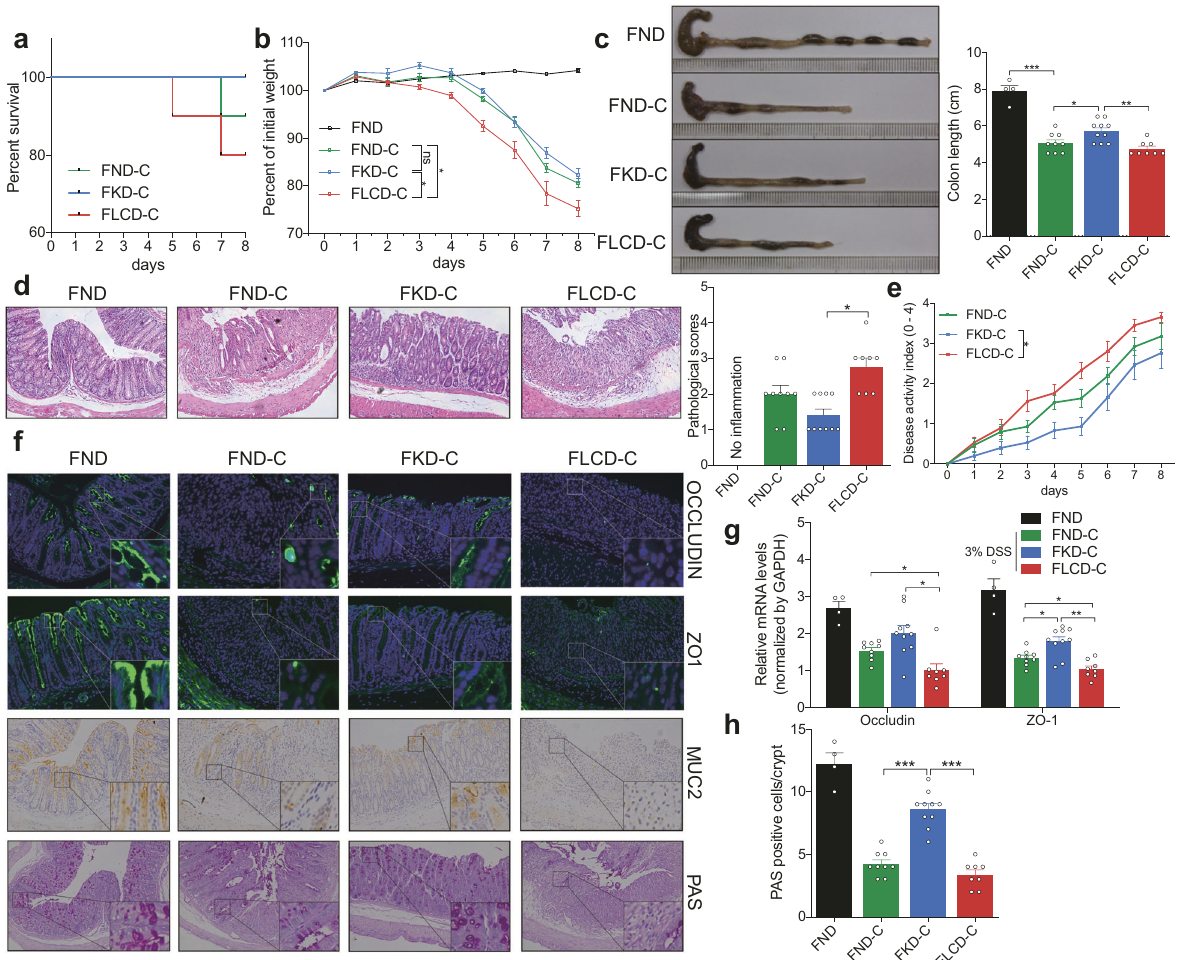
Fig. 6 Effect of FMT from KD- and LCD-fed mice on in fl ammatory responses and mucosal barrier function in colitis-induced germ-free mice. a Survival curves of DSS-induced colitis germ-free mice after FMT from mice fed with KD (FKD-C), LCD (FLCD-C), or ND (FND-C; control). b Body weight change in mice receiving 3% DSS in drinking water. c Representative colon images on 1 week after DSS induction and colon length shown as a chart. d Representative colon H&E staining images (original magni fi cation ×200). Right: colonic section pathological scores. e DAI in each group. f Representative immuno fl uorescence, IHC and PAS staining images of colon tissues with antibodies against Occludin, ZO-1, and MUC-2 (original magni fi cation ×200). g Colon Occludin and ZO-1 mRNA expression measured by qRT-PCR. h Number of PAS-positive cells per villus/crypt. * p < 0.05; ** p < 0.01; *** p < 0.001. (FKD-C, n = 10; FLCD-C, n = 8; FND-C, n = 9; FND, n = 4). Results are expressed as mean ± SEM ( b – e , g , h ). KD ketogenic diet, LCD low-carbohydrate diet, ND normal diet, DSS dextran sulfate sodium, DAI disease activity index,